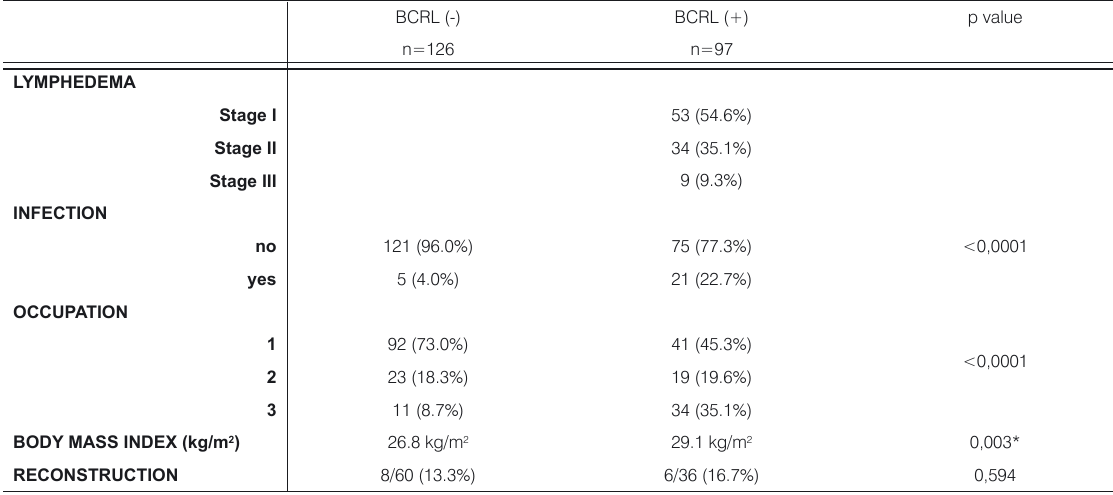
Table 3. Parameters associated with